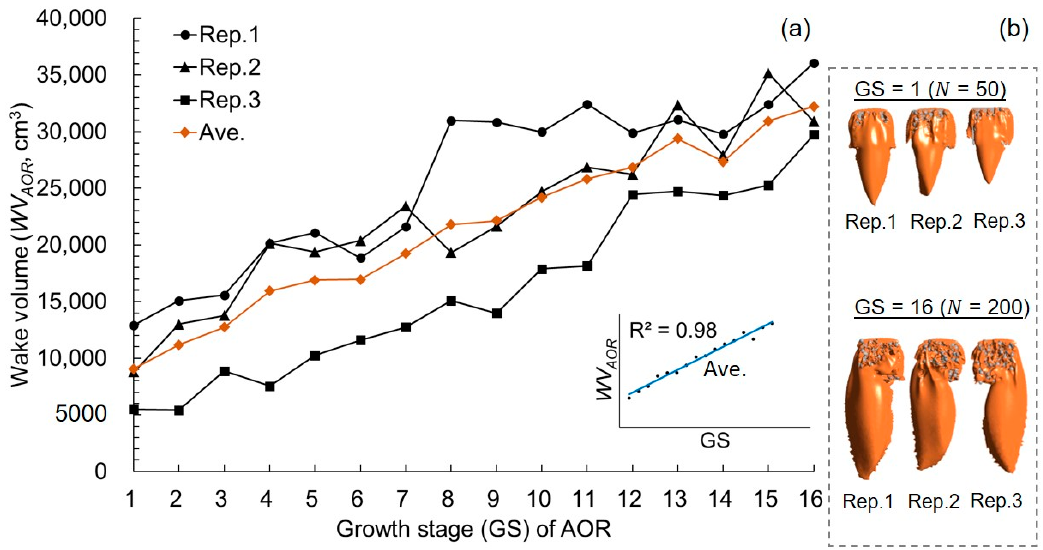
Figure 8. Wake volumes of the growth AOR models: ( a ) correlation between the wake volumes and the growth stages (GSs) and ( b ) plane views of wake volumes when GS = 1 and GS = 16, respectively.